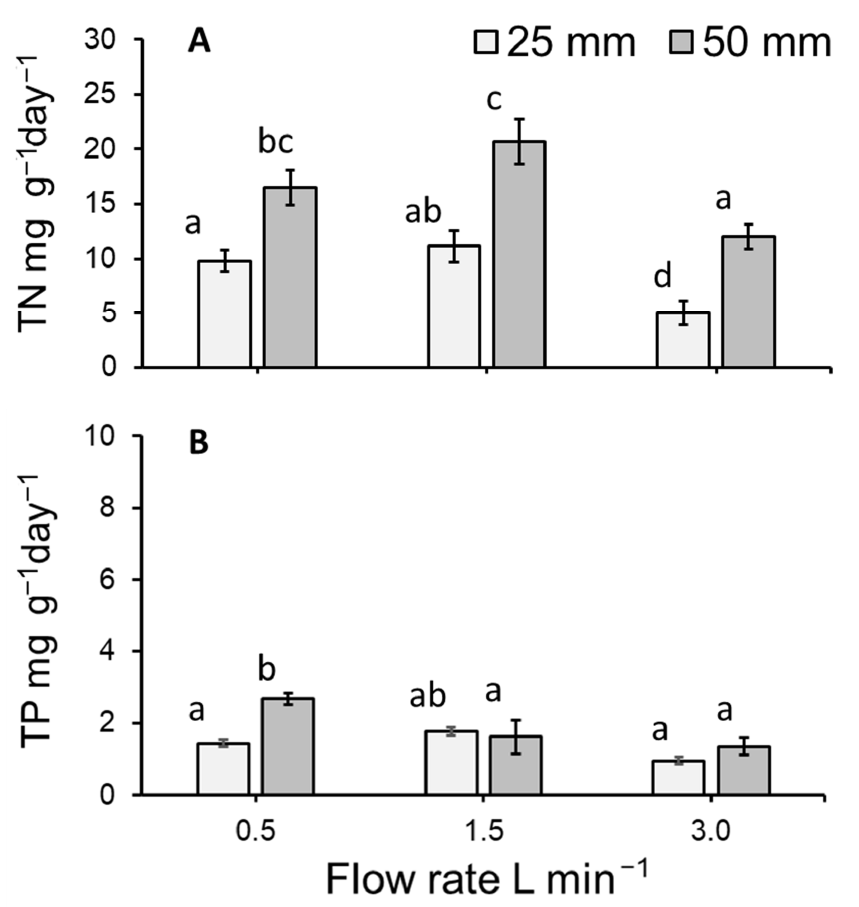
Figure 8. Mean ( ± SE) ( A ) TN and ( B ) TP uptake per gram of Lemna minor per day (mg g − 1 day − 1 ) for the biomass of plants cultivated on hydroponics medium at three flow rates and two medium depths over 7 days. As no effect of tray was detected, trays have been pooled in this simplified model depiction. Letters show statistical similarity within each panel ( p > 0.05).